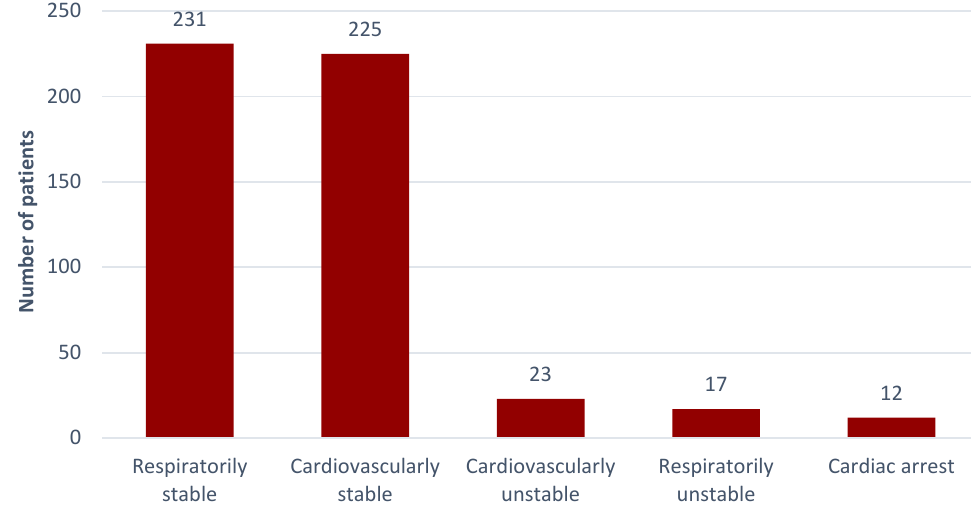
Figure 4. Assessment of the circulatory and respiratory efficiency of the injured.